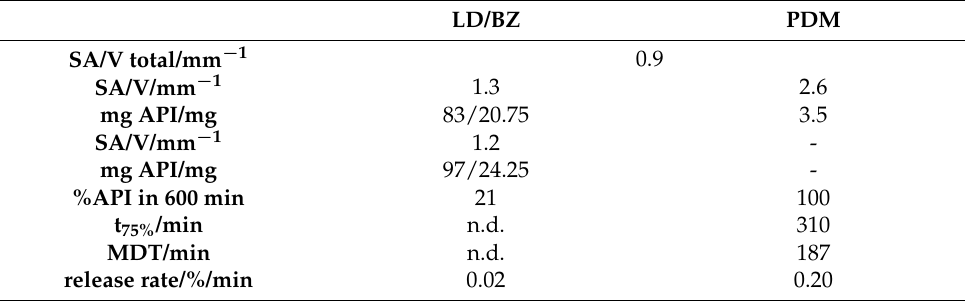
Figure 8. ( Left ): release profile of PP2; modified basket apparatus, 1000 mL 0.1 N HCl, 50 rpm, 37.0 ± 0.5 °C, x ± s; n = 3. ( Right ): Image of PP2: red: PDM-PVA, blue: LD/BZ-EVA.